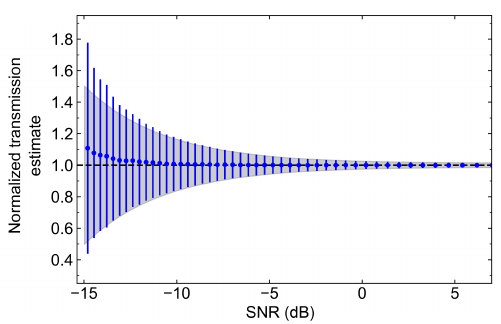
Figure B1. Statistics of low-SNR estimation of two-way trans- mission. The blue data points represent the means and standard deviations of the Monte Carlo probability distributions, while the gray shaded area represents the error calculated using Eq. (8). For SNR < − 10dB, the systematic bias of the Monte Carlo mean and the underestimation of the true error by Eq. (8) imply that measure- ments in this region should be disregarded. In order to access lower values of SNR, one must increase the number of pulses N p for each